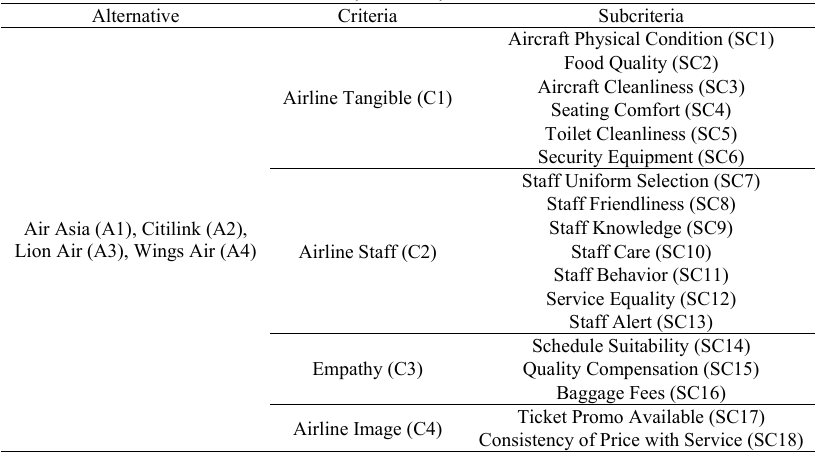
TABLE 2 A LTERNATIVE , C RITERIA , AND S UB -C RITERIA